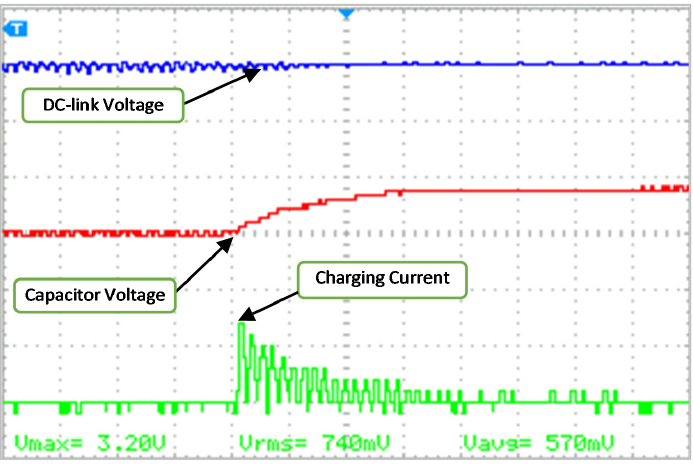
Figure 16. DC-link charging of capacitor Ca.